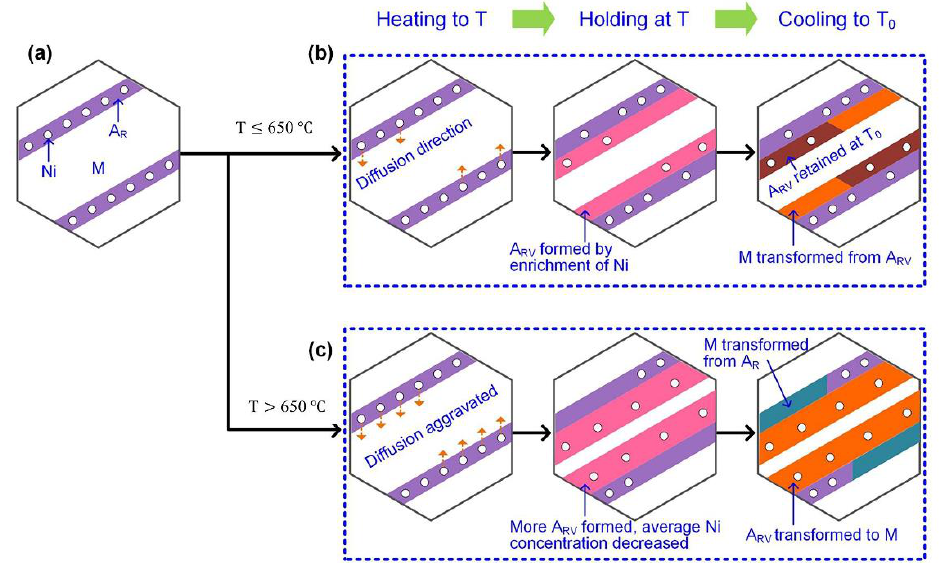
Figure 4. Schematic illustrations for reverted austenite formation treated by diverse heating tem- perature [4]: ( a ) The as-welded specimen, ( b ) applying heat treatment temperature below 650 °C, ( c ) applying heat treatment temperature above 650 °C. (Reprinted with permission from Ref. [4]. Cop- yright 2019 Elsevier).